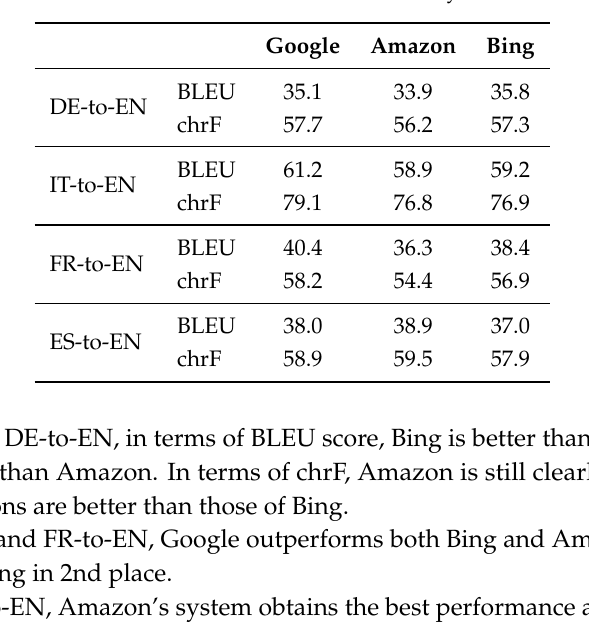
Table 4. Performance of online NMT